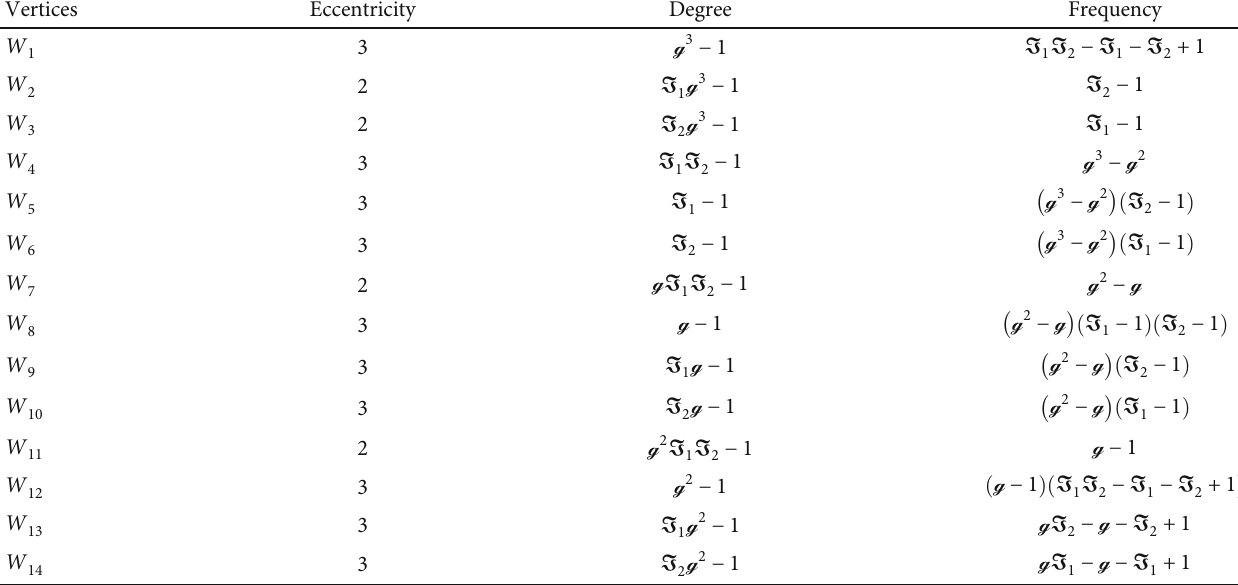
× ℤ ℊ 3 I 1 I 2 Þ